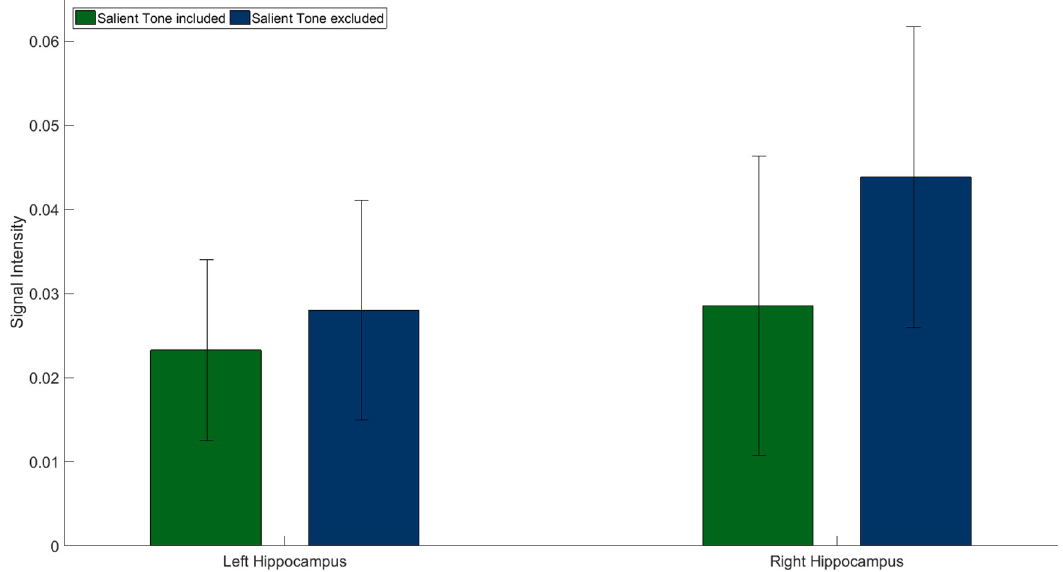
Fig 4. Effects of the memory specific covariate within ROI centered on coordinates of the left and the right hippocampus (contrast estimates and 90% confidence interval). A similar pattern of the memory specific covariate can be found in both analyses, when the salient tone is included (green; left: T(43) = 5.56, p = 0.001; right: n.s. after correction for multiple comparison) and excluded (blue; left: T(32) = 3.52, p = 0.001; right: T(32) = 4.03, p < 0.001) from analysis. However, the effect of the memory specific covariate is enhanced when the salient tone is